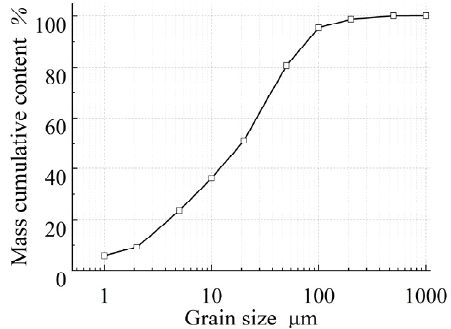
Figure 6. Particle size distribution diagram. Table 1. Mechanical composition of soil.